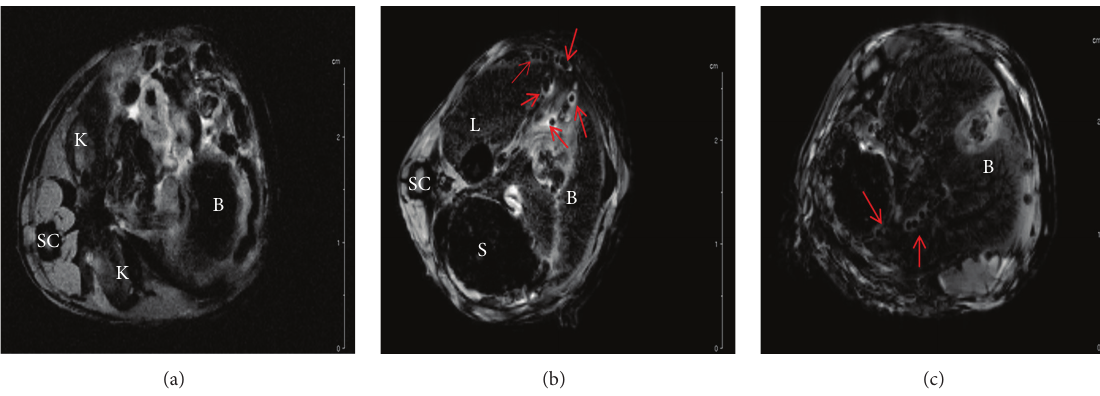
Figure 6: In vivo MRI of encapsulated MM-labelled cells by 11.7T scanner. MR images of the abdominal cavity of mice on the day they were transplanted with encapsulated unlabelled MIN6 (a) and encapsulated MM-labelled MIN6 (b and c). The arrows point to single as well as clusters of encapsulated MM-labelled MIN6 which appear as discrete hypointensities and are spread throughout the peritoneal cavity. The letters on the figure identify different organs as follows: B is for bowel, K is for kidney, L is for liver, S is for spleen, and SC is for spinal